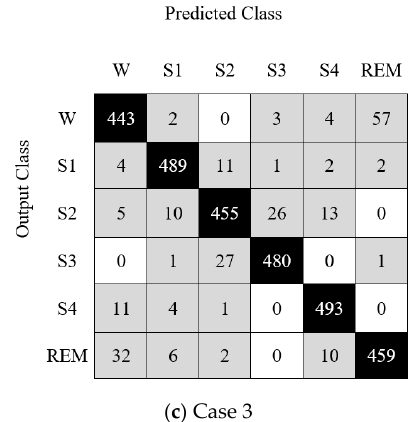
Figure 6. Confusion matrix for each case. The confusion matrices in Figure 6 denote the case-specific results.